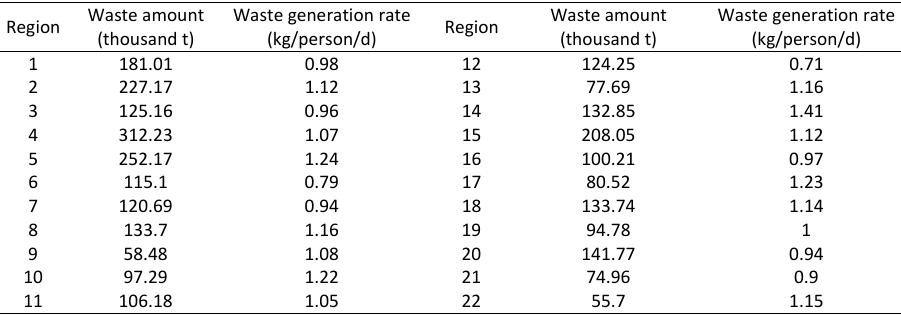
Table 2: The amount of municipal solid waste production in Tehran in 2017 (TWMO, 2018) Table 2. The amount of municipal solid waste production in Tehran in 2017 (TWMO, Region